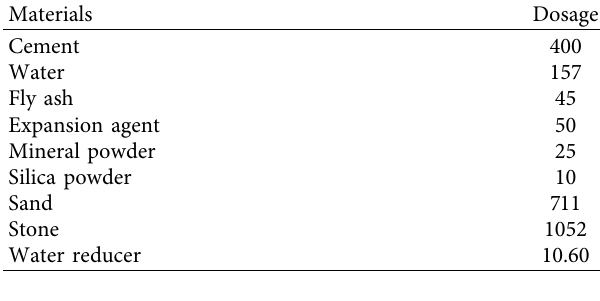
Table 1: Mix proportions of test concrete (kg/m 3 ).